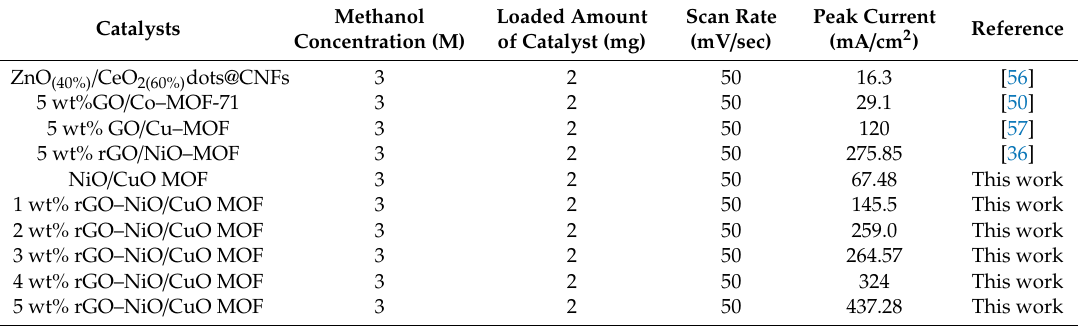
Table 2. Comparison of methanol concentrations, scan rates and current densities along with reported electro catalysts for methanol oxidation.